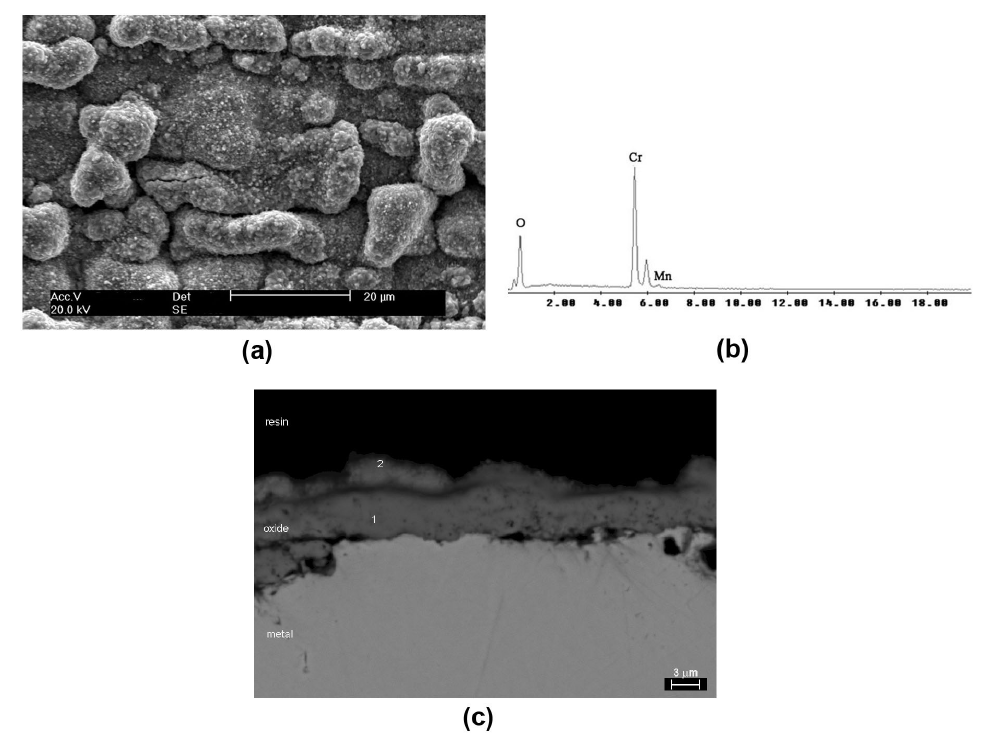
Figure 6: Scanning electron micrographs and the EDS spectrum of Fe-20Cr alloy specimen after 15 cycles of oxidation for 7 h at 1000 °C. (a) The surface; (b) the EDS spectrum of the surface; (c) the cross-section.